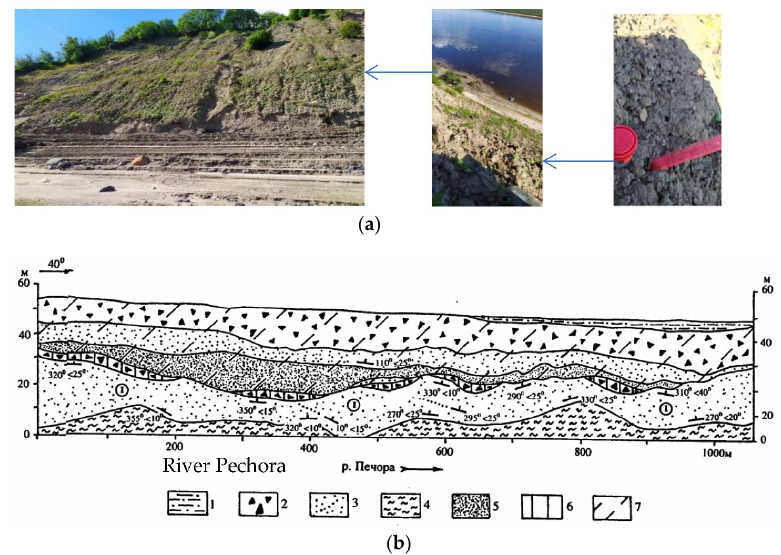
Figure 5 . Scheme of the Khongurei outcrop structure reproduced with permission from [62]. ( a ) Khongurei outcrop and the site of collection of fragments of mollusk shells (blue arrow). ( b ) Geo- logical structure of the Khongurei outcrop: 1: late glacial banded clays of the Ostashkov glaciation; 2: boulder loams of the Ostashkov glaciation; 3: predominantly sandy sediments; 4: clayey silts of Mikulin age; 5: glaciodislocated Mikulin clays; 6–7: Ostashkovskaya scaly moraine; 6: lower scales; 7: upper scales. I: Karginsky alluvial deposits .